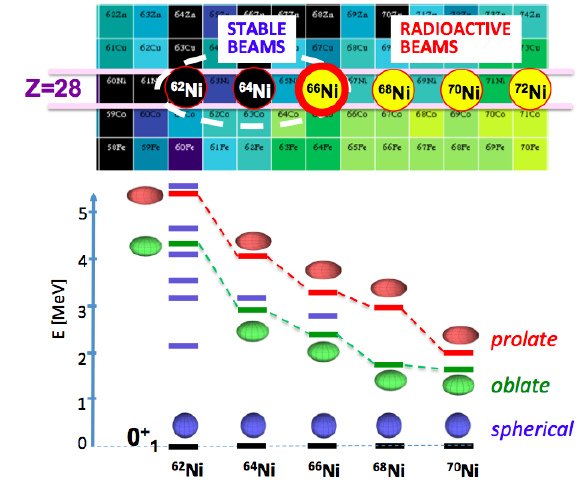
Fig. 1. Top: region of the nuclear chart focusing on neutron-rich Ni isotopes in the proximity of the valley of stability. Even-even A=62, 64, 66 (and the even-odd 65), are currently investigated by the present collaboration, employing intense stable ion beams and neutron beams. Heavier Ni isotopes require, instead, intense radioactive beams. Bottom: Monte Carlo Shell Model predictions for 0 + states of spherical (blue), oblate (green) and prolate (red) shape, for Ni isotopes between A = 62 and